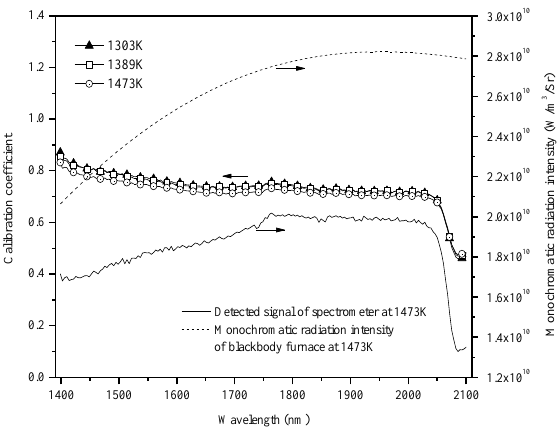
Figure 2. Characteristic calibration for the spectrometer.